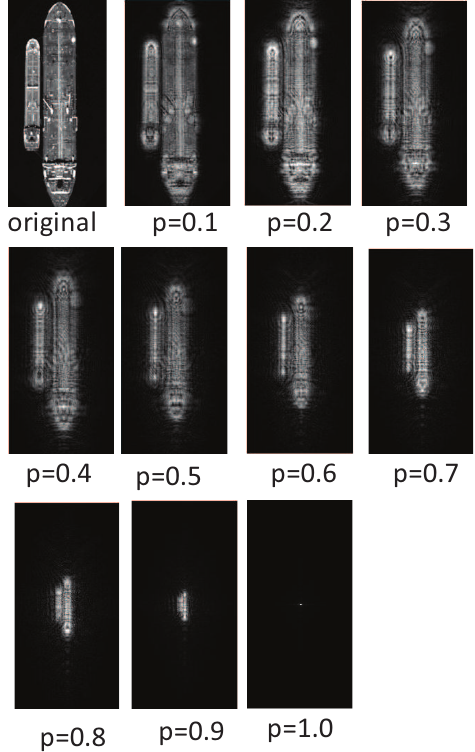
Figure 2. The inverse 2D-DFrFT amplitude information corresponding to different orders.